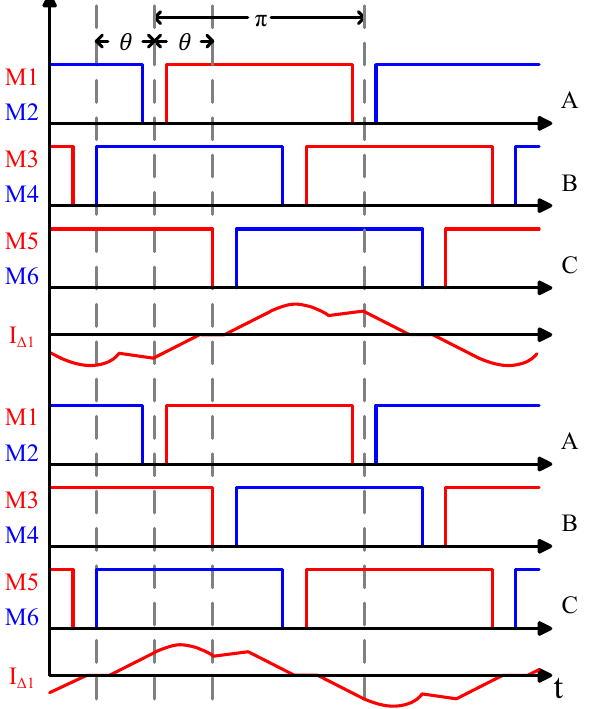
Figure 2. Influence of switching at deferent sequence.